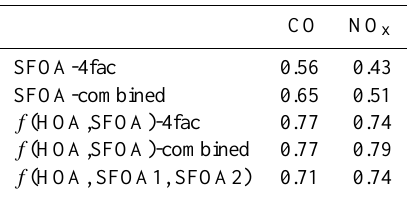
Table 1. Pearson’s r correlation coefficients for linear and multi- linear regressions between PMF factors from the 4- and 5-factor solutions and combustion